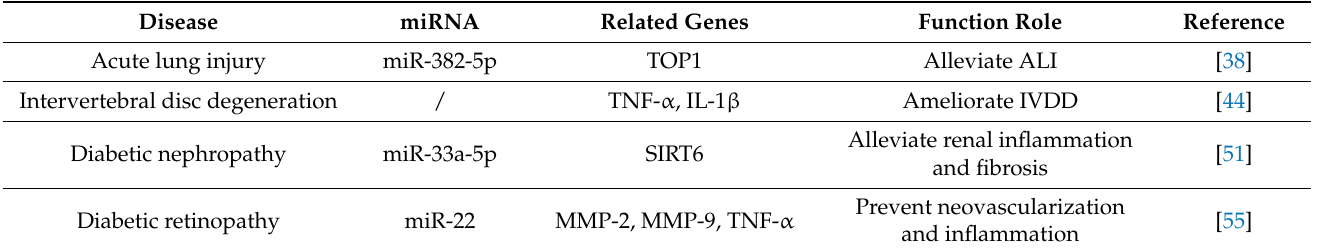
Table 3. Target and role of circ-ITCH in